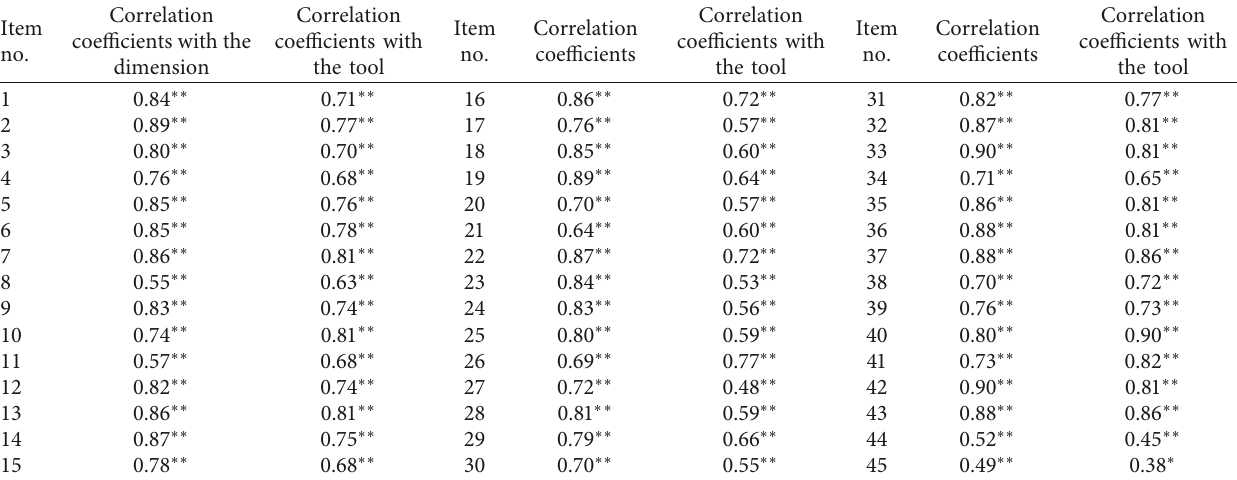
Table 2: Items, total score, and dimension correlation coefficients.